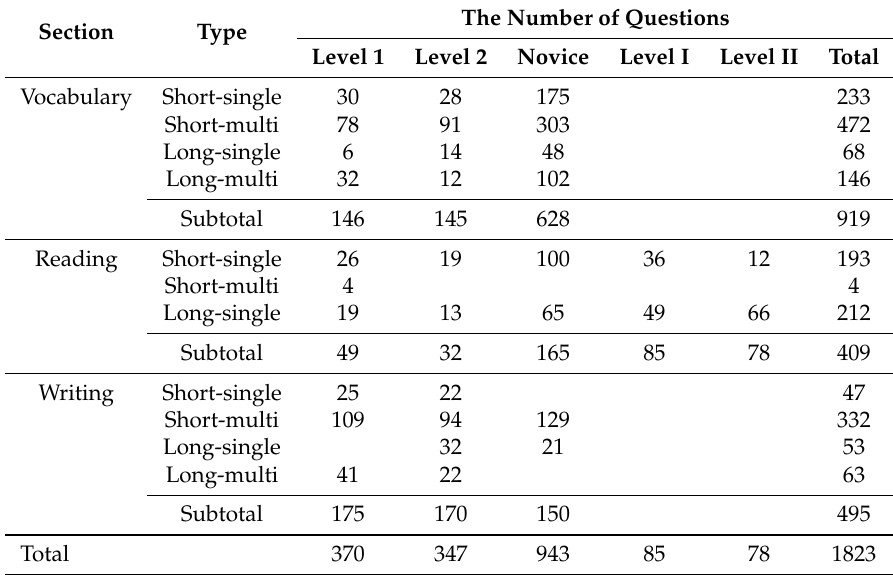
Table 8. Statistics of the cloze-style questions collected from previous TOPIK tests.